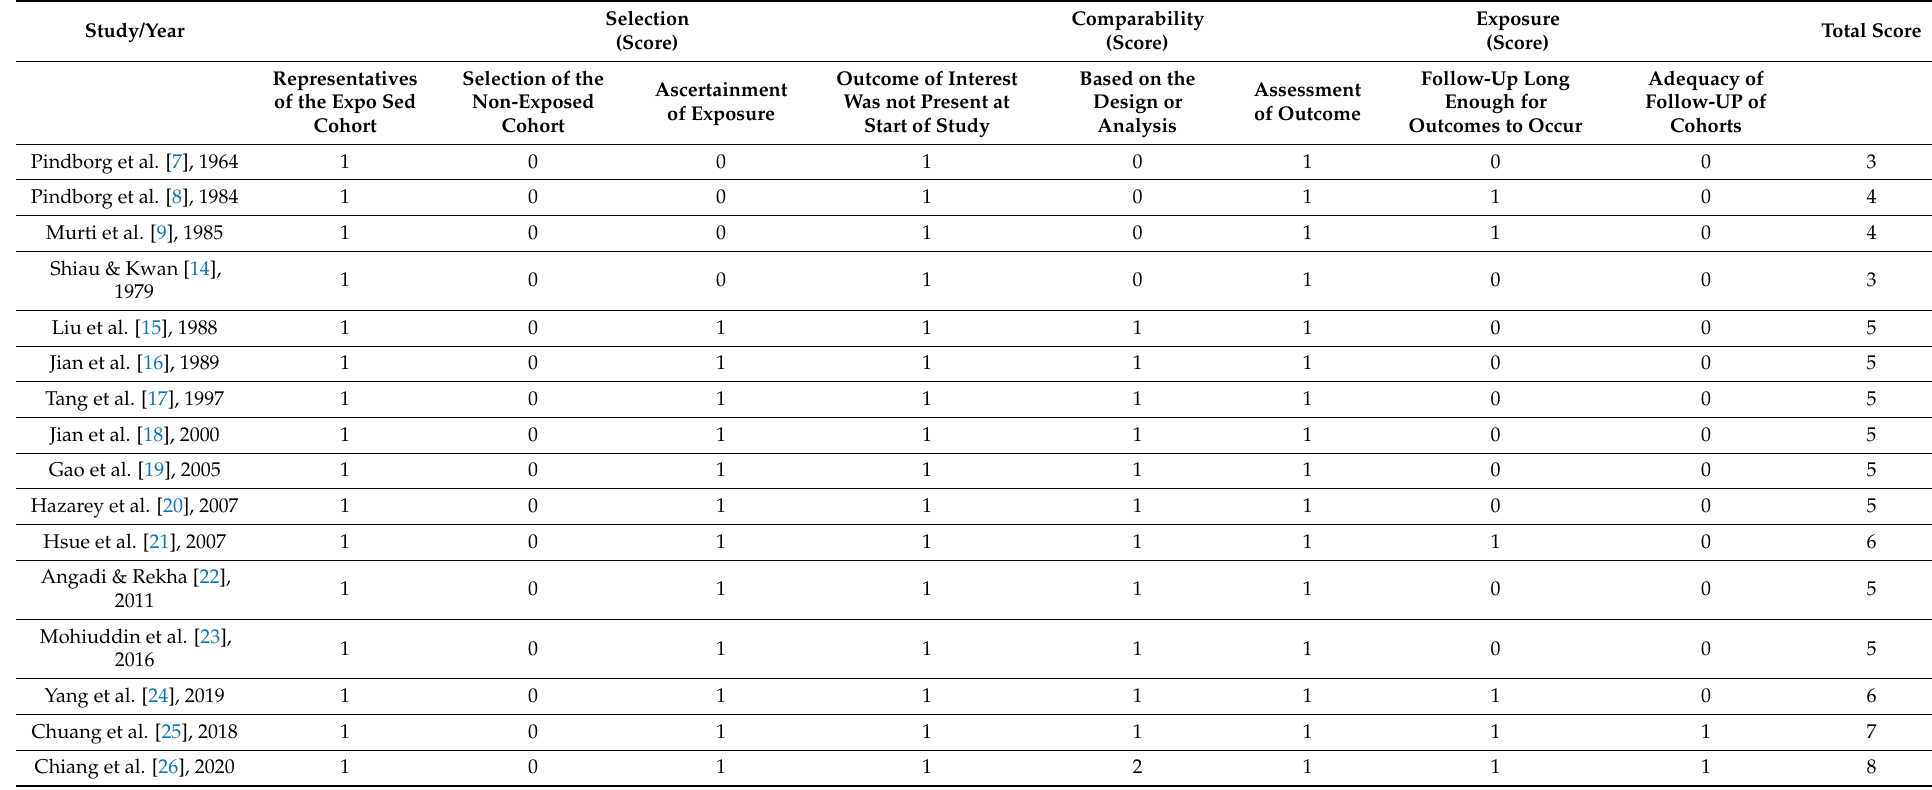
Table 2. Quality assessment of included studies based on the Newcastle–Ottawa Scale (NOS) for assessing the quality of cohort